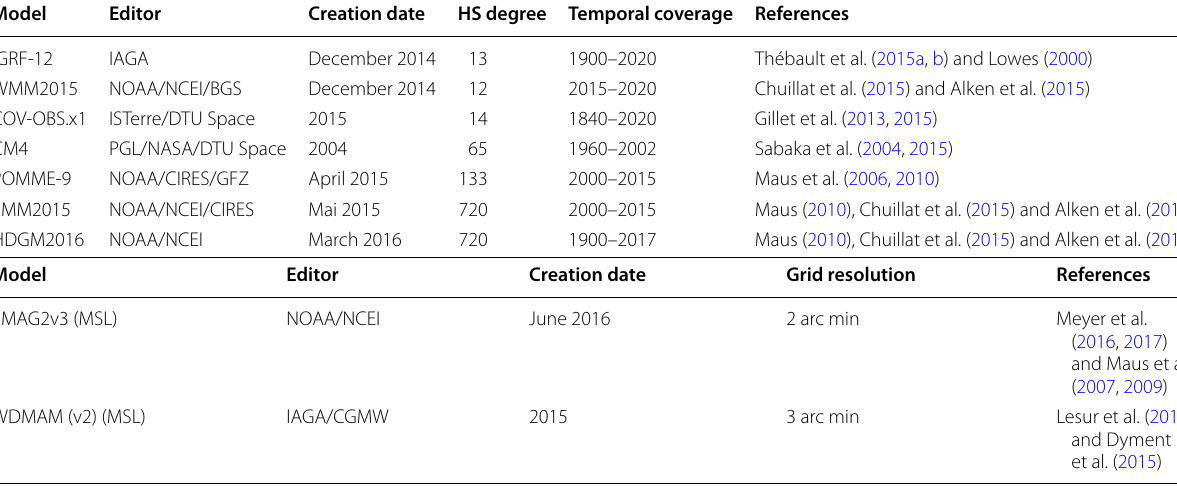
Table 1 Main characteristics of the evaluated global geomagnetic field